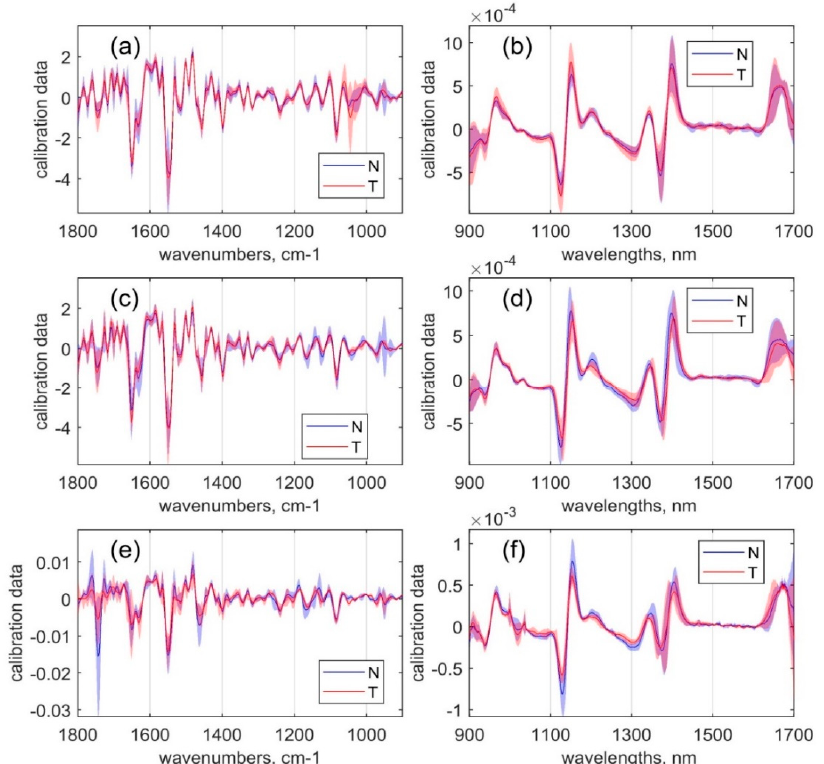
Figure 5. Calibration data (CD) of models built using single methods (before removing the mean centre): ( a ) CD of model #5—MIR dataset pretreated by 2D, SNV including only colon measurements; ( b ) CD of model #4—NIR dataset pretreated by 2D including only colon measurements; ( c ) CD of model #8—MIR dataset pretreated by 2D, SNV including only stomach measurements; ( d ) CD of